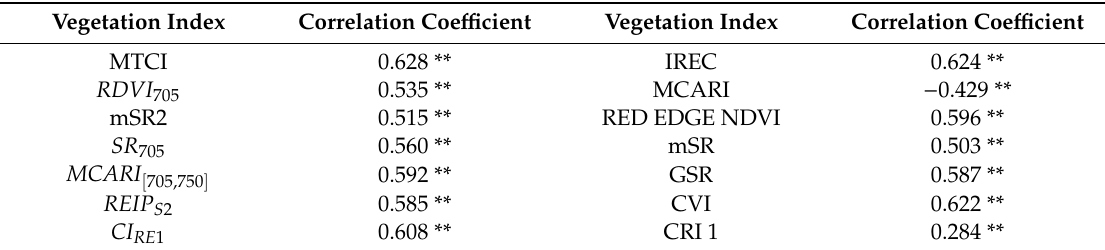
Table 8. Correlation between spectral parameters and wheat GPC from Trial 1 and Trial 2 ( n = 80).